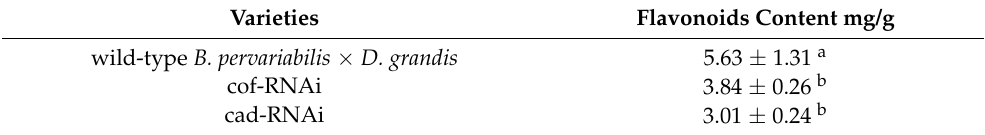
Table 3. Flavonoid content in transgenic